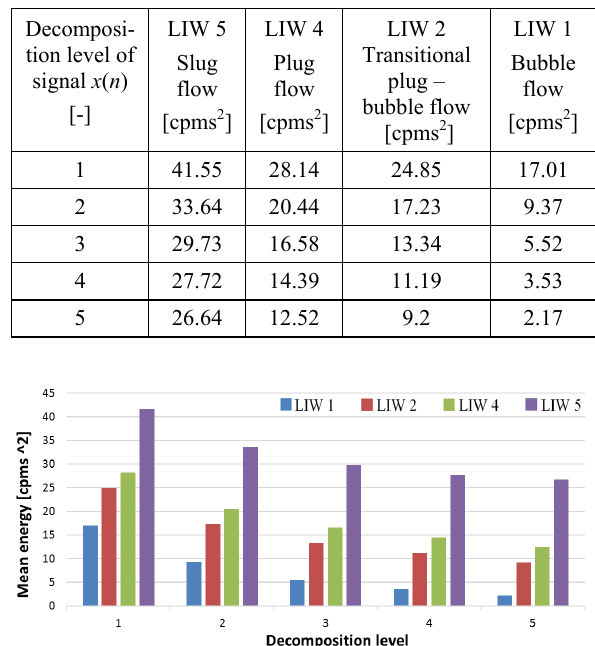
Table 1 . The mean energy values of the approximations for different types of flow (db2 wavelet ).